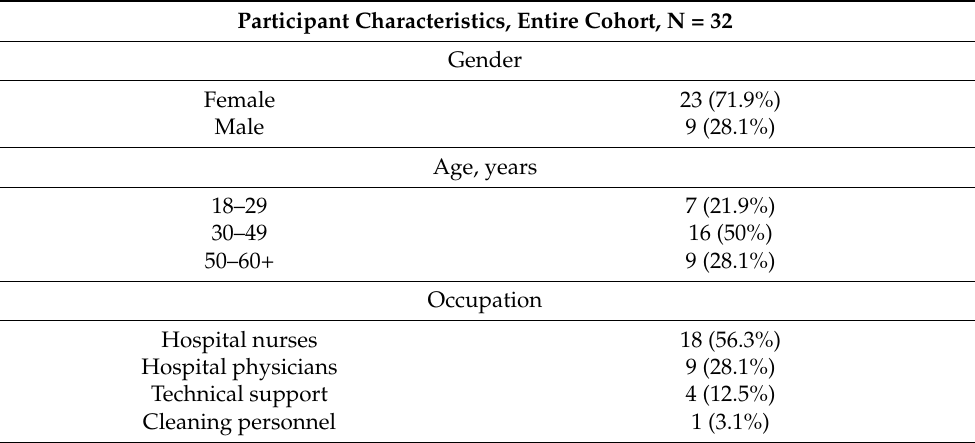
Table 1. Demographic characteristics associated with respondent